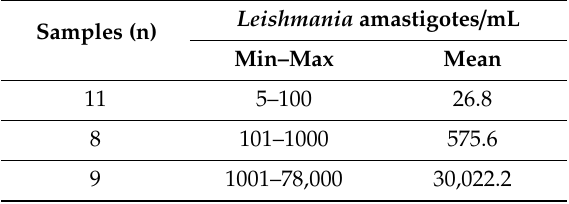
Table 4. Mean of Leishmania amastigotes / mL in the 28 Rt-PCR positive samples, divided in three